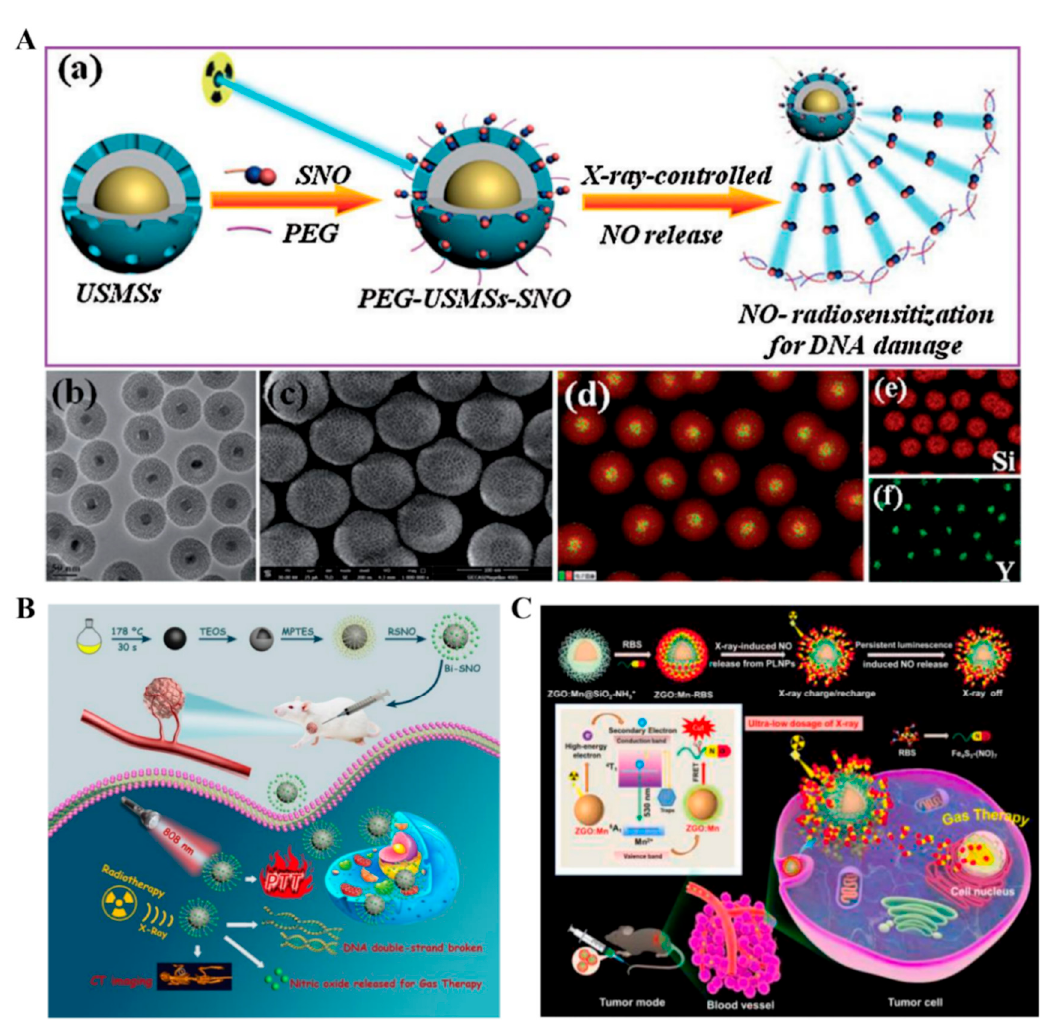
Figure 6. ( A ) ( a ) Schematic diagram of PEG–USMSs–SNO construction; ( b ) transmission electron microscope images of USMSs; ( c ) SEM images of USMSs; ( d ) elemental mapping of the merging of Si and Y of USMSs; ( e ) elemental mapping of merging of Si of USMSs; ( f ) elemental mapping of merging of Y of USMSs (USMSs: a dense silica shell was coated on upconversion nanoparticles). Reproduced with permission from [94], Angewandte Chemie International Edition, 2015. ( B ) schematic diagram of the preparation of Bi–SNO-NPs and the process of enhanced NO therapy with X-ray irradiation in cancer cells. Reproduced with permission from [95], Nanoscale, 2020. ( C ) schematic diagram of the preparation of the ZGO:Mn-RBS nanosystem and the process of anti-tumor effects. Reproduced with permission from [96], Biomaterials, 2020.